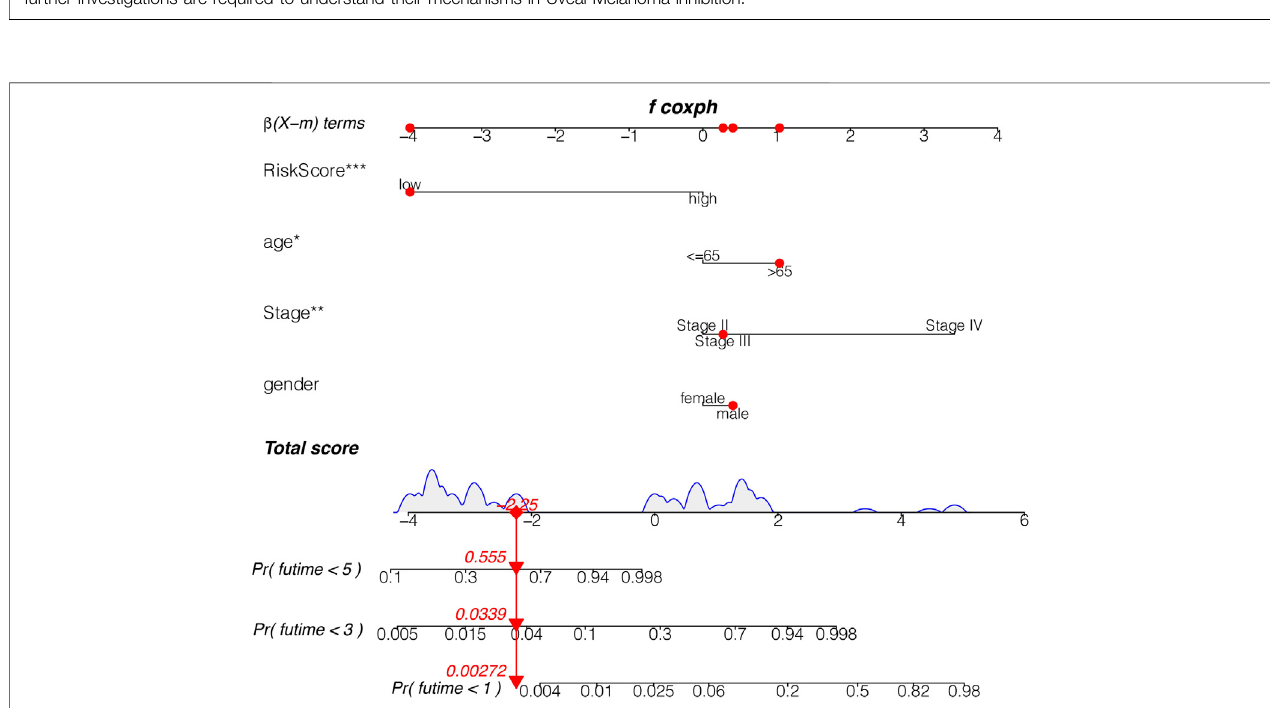
FIGURE 10 | The nomogram. The 1, 3, and 5 mortality rates of patient “ TCGA-VD-A8KH ” were 0.00272, 0.0339 and 0.555, respectively.